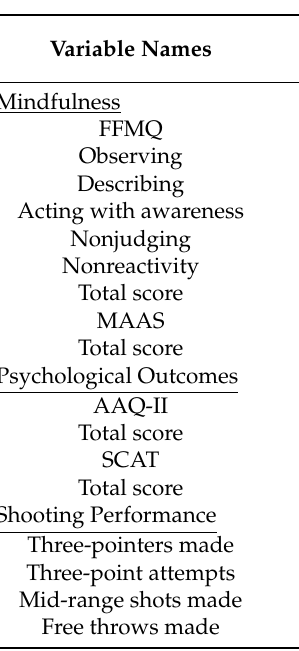
Table 3. Between-group difference at